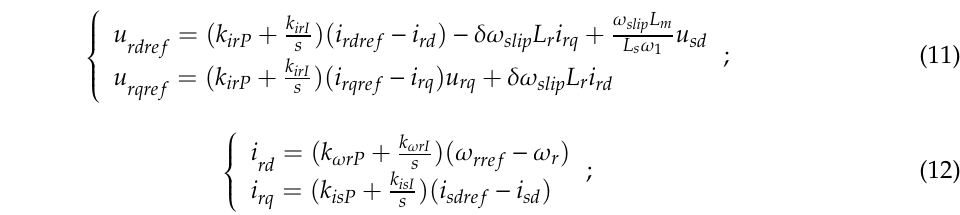
Figure 5. The small-signal transfer diagram of the RSC circuit in DFIG.